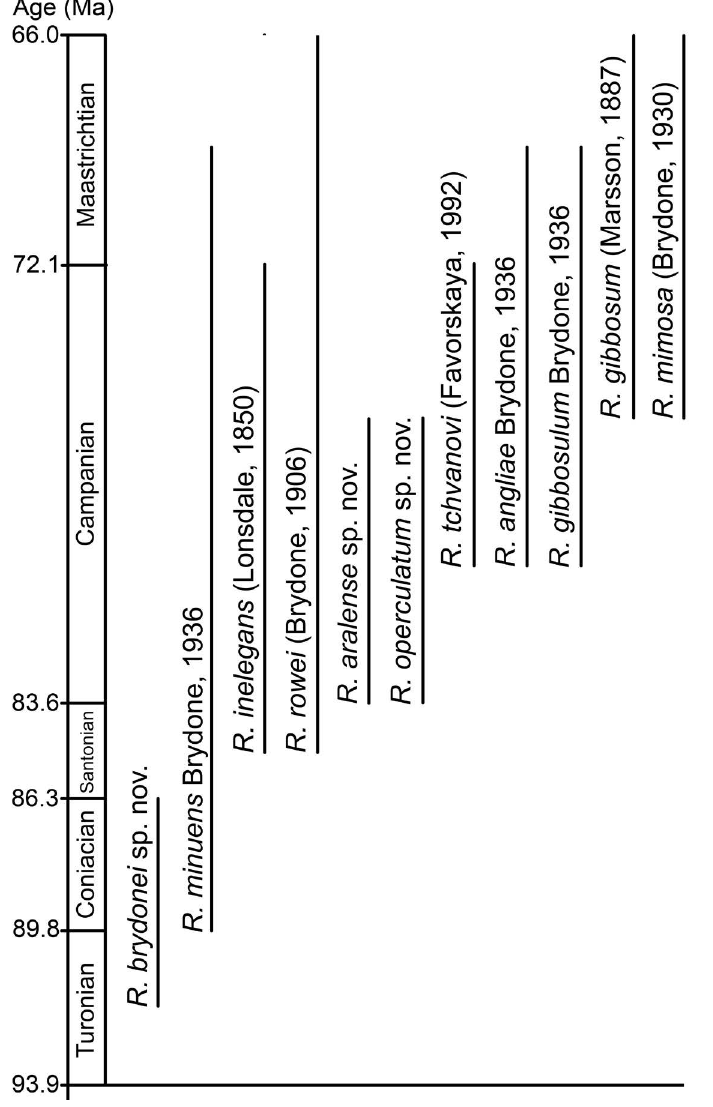
Fig. 20. Distribution of the studied species of the genus Rhagasostoma Koschinsky, 1885 in the Late Cretaceous of